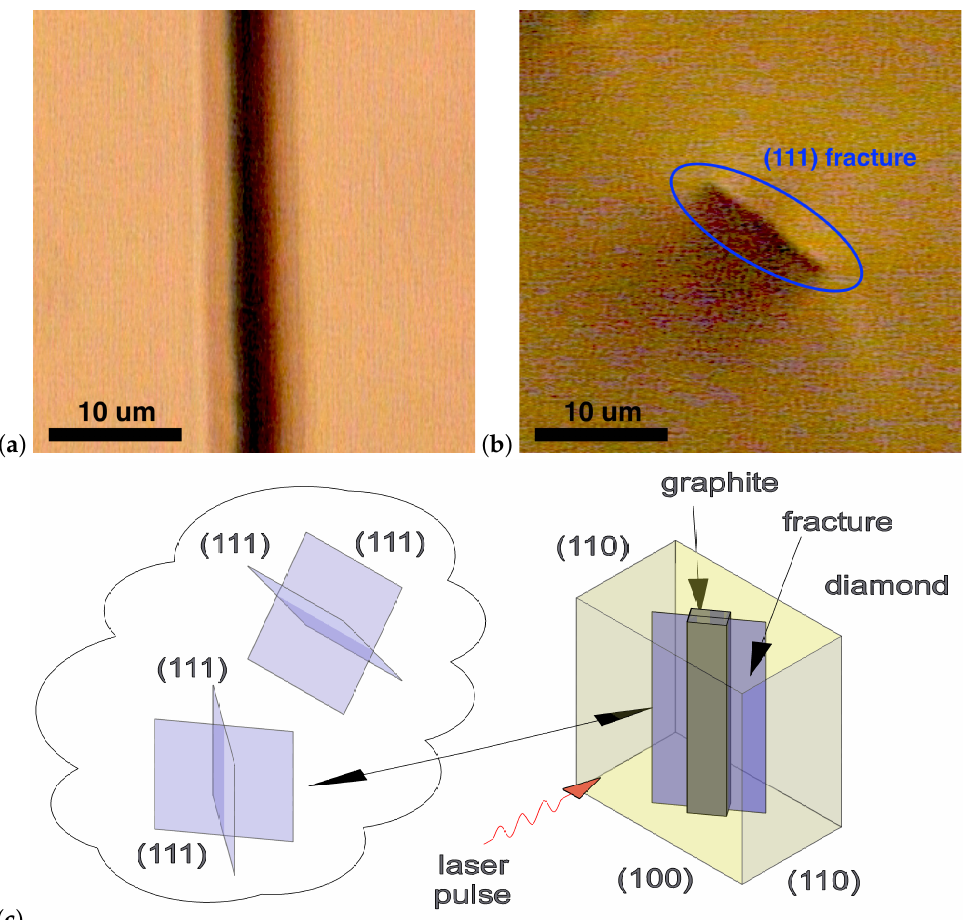
Figure 5. Formation of (111) oriented fracture in diamond bulk: ( a , b ) optical images of dominant fracture and graphitized ribbon localized inside; ( c ) scheme of cleavage-driven graphitization devel- opment. Insert illustrates 4 possible orientations of the (111) plane in the crystal